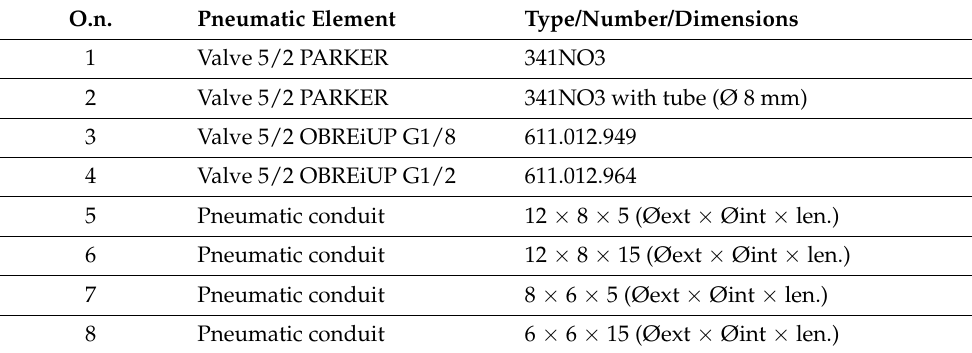
Table 2. List of catalog parameters of pneumatic elements.